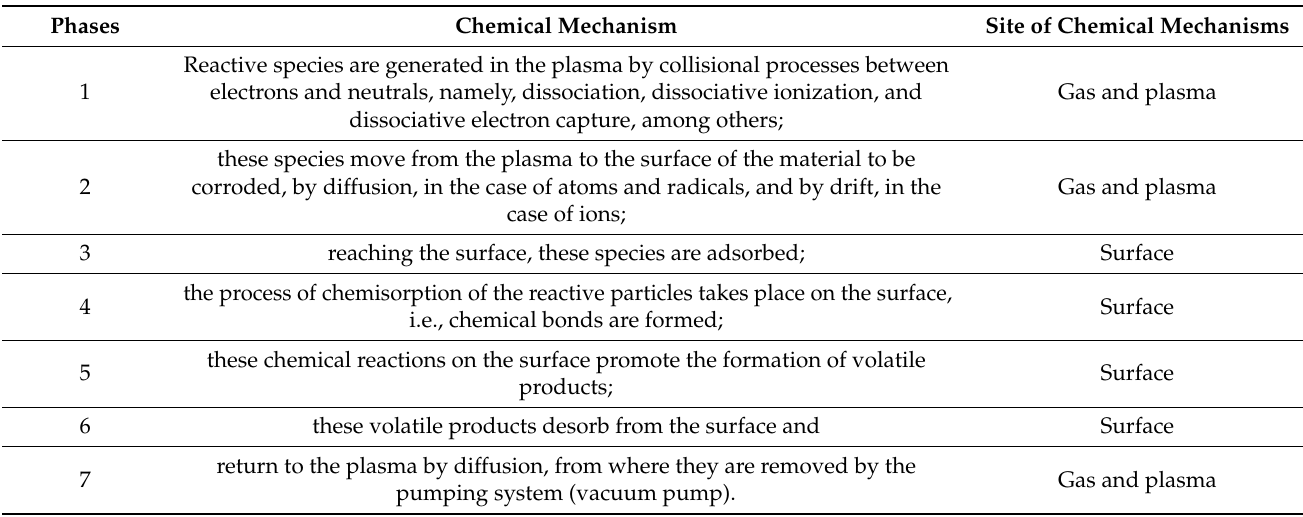
Table 4. Standard etching mechanisms performed by plasma (Dry